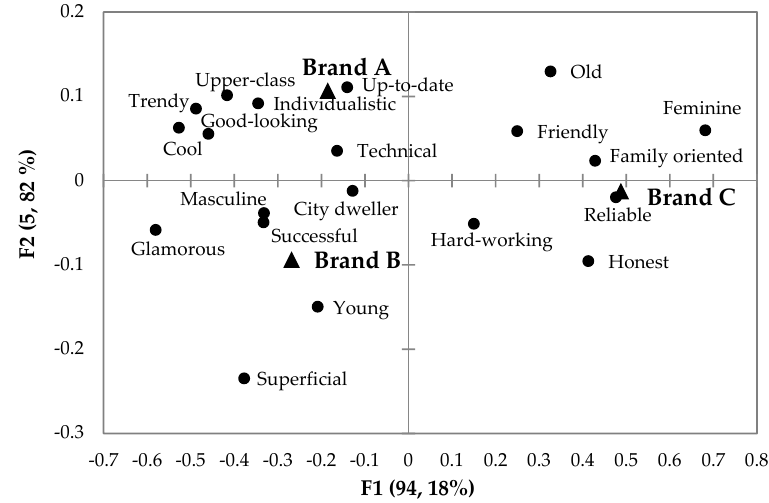
Figure 3. Factorial correspondence analysis of brand personality traits with significant difference according to Cochran’s Q test: Uruguay. Beverages 2017 , 3 , 11